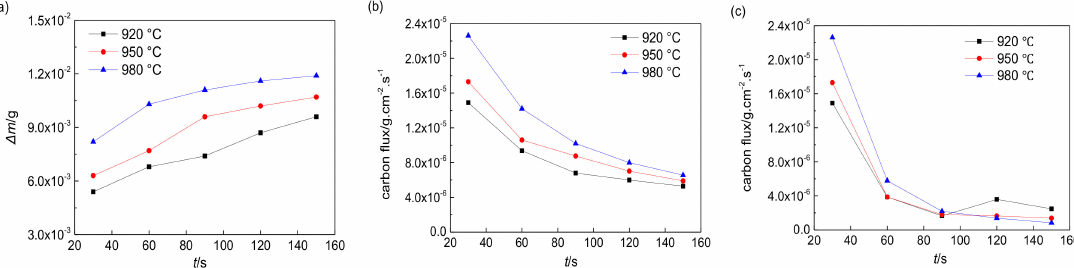
Figure 11. E ff ect of carburizing temperature on ( a ) mass increment, ( b ) average carbon flux, and ( c ) segmented average carbon flux of 16Cr3NiWMoVNbE steel under 300